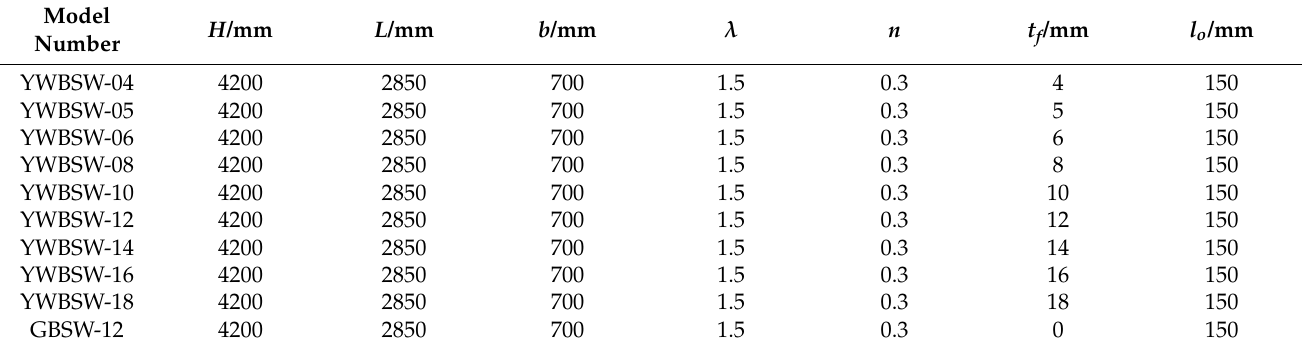
Table 3. Parameters of shear wall models with different fishplate